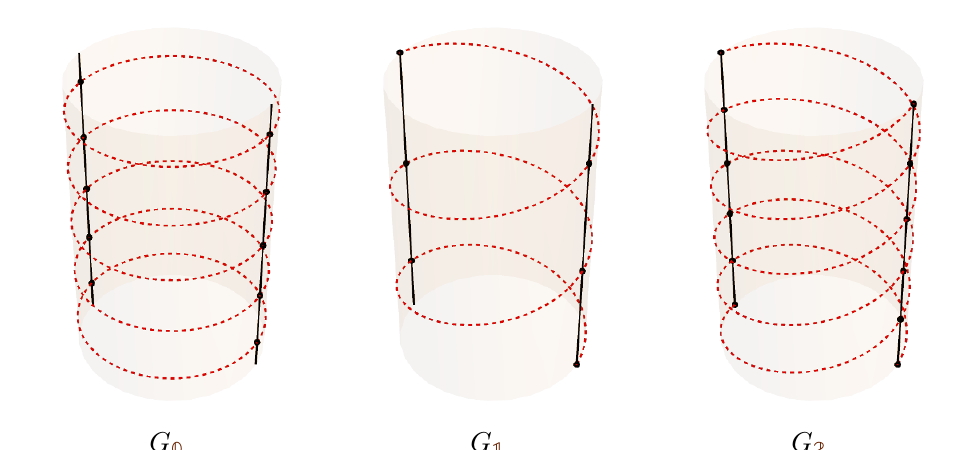
Figure 1 . Three types of the 4-points functions topologies. These cases differ by the number of “particles” (red dashed lines) transfered from the bottom to the top. These particles can be associated in terms of the ABA with magnons in the intermediate states on the OPE. We refer to them as zero, one and two particle cases correspondingly. The black lines correspond to the X